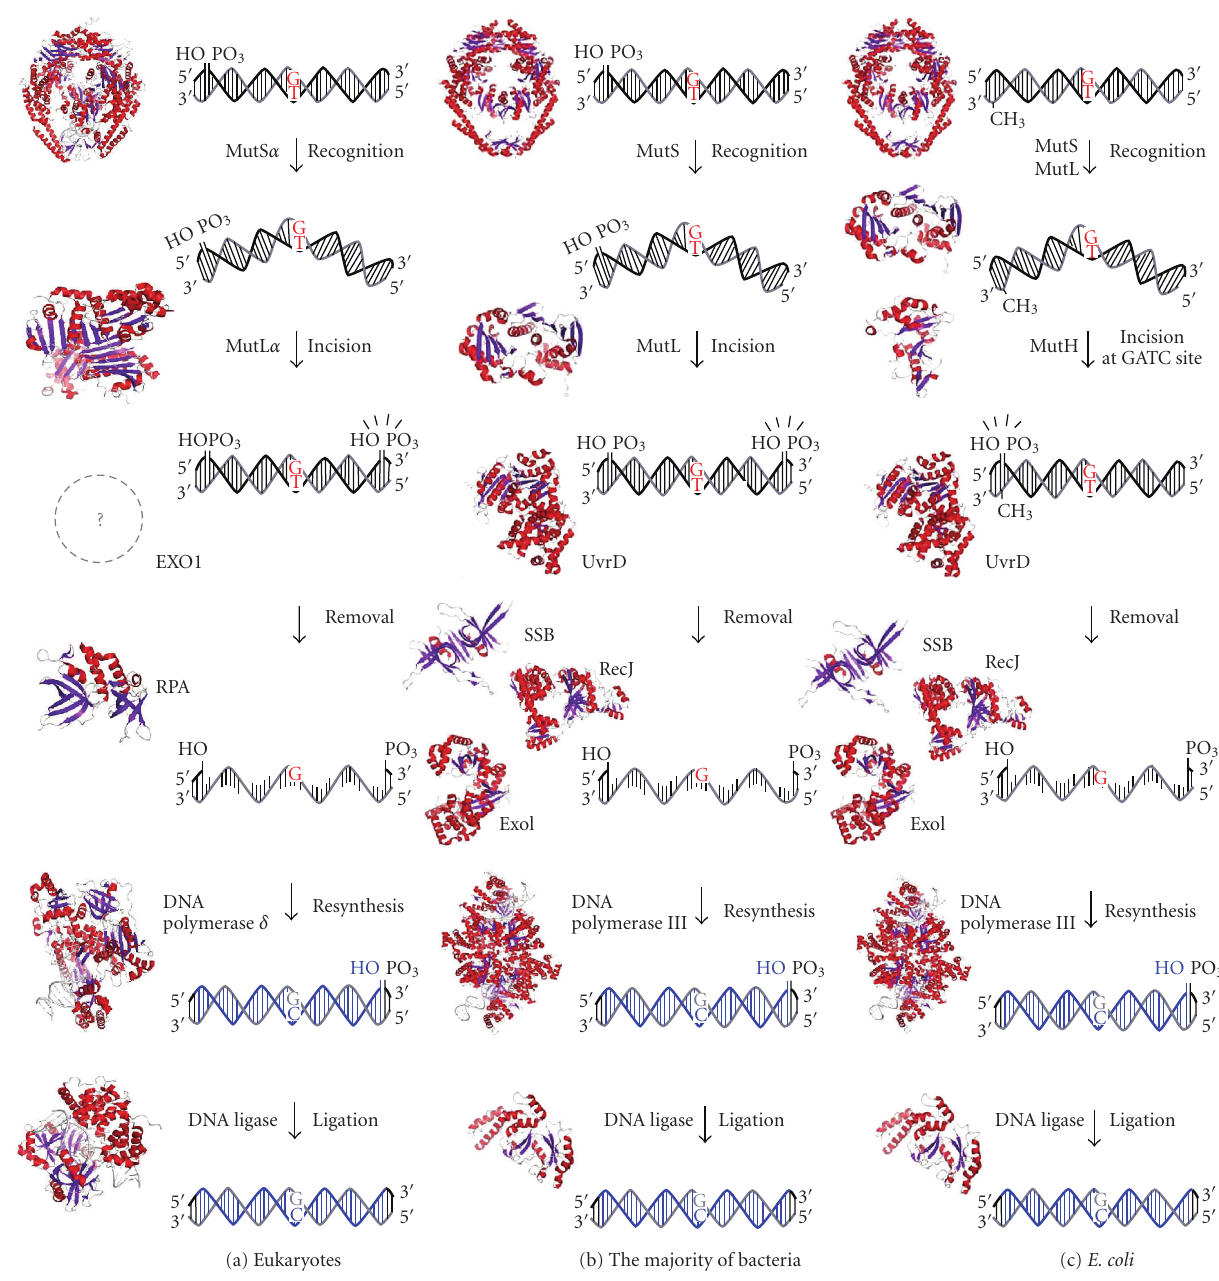
Figure 1: A schematic representation of MMR pathway models. (a) Eukaryotic MMR. A DNA mismatch is generated by the misincorporation of a base during DNA replication. MutS α recognizes base-base mismatches and MutL α nicks the 3 (cid:2) - or 5 (cid:2) -side of the mismatched base on the discontinuous strand. The resulting DNA segment is excised by the EXO1 exonuclease, in cooperation with the single-stranded DNA-binding protein RPA. The DNA strand is resynthesized by DNA polymerase δ and DNA ligase 1. (b) MMR in mutH - less bacteria. Mismatched bases are recognized by MutS. After the incision of discontinuous strand by MutL, the error-containing DNA strand is removed by the cooperative functions of DNA helicases, such as UvrD, the exonucleases RecJ and ExoI, and the single-stranded DNA-binding protein SSB. DNA polymerase III and DNA ligase fill the gap to complete the repair. (c) E. coli MMR. MutS recognizes mismatched bases, and MutL interacts with and stabilizes the complex. Then, MutH endonuclease is activated to incise the unmethylated GATC site to create an entry point for the excision reaction. DNA helicase, a single-stranded DNA-binding protein, and several exonucleases are involved in the excision reaction. PDB IDs of crystal structures in this figure are 2O8B (human MutS α ), 1H7S (human MutL α ), 1L1O (human RPA), 3IAY (human DNA polymerase δ ), 1X9N (human DNA ligase 1), 1E3M (bacterial MutS), 1B63 (bacterial MutL), 2AZO ( E. coli MutH), 2ISI (bacterial UvrD), 2ZXO (bacterial RecJ), 3C95 (bacterial ExoI), 2CWA (bacterial SSB), 2HQA (bacterial DNA polymerase III), and 2OWO (bacterial DNA